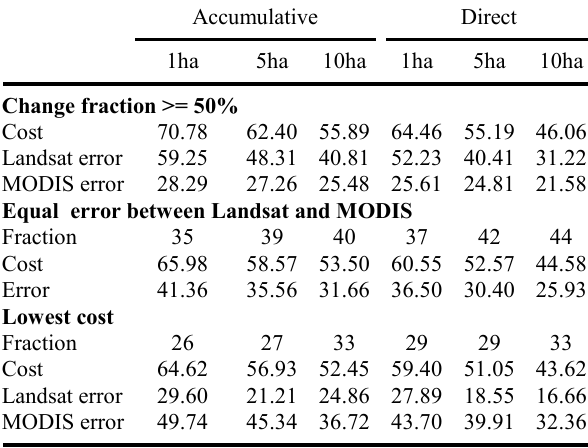
Table 7. Cost, fraction and error statistics (all in percent) for the Pareto